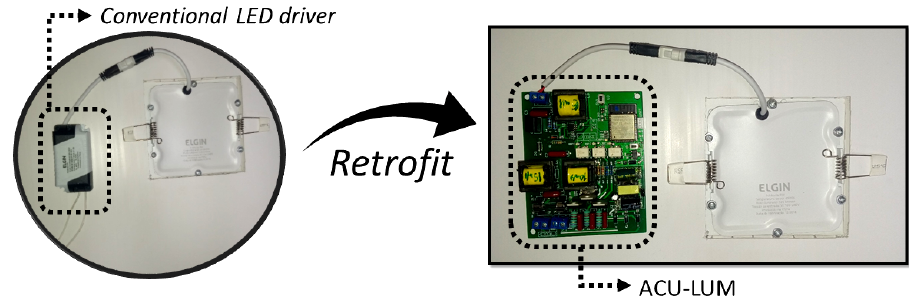
Figure 8. Retrofit method for ACU-LUM.